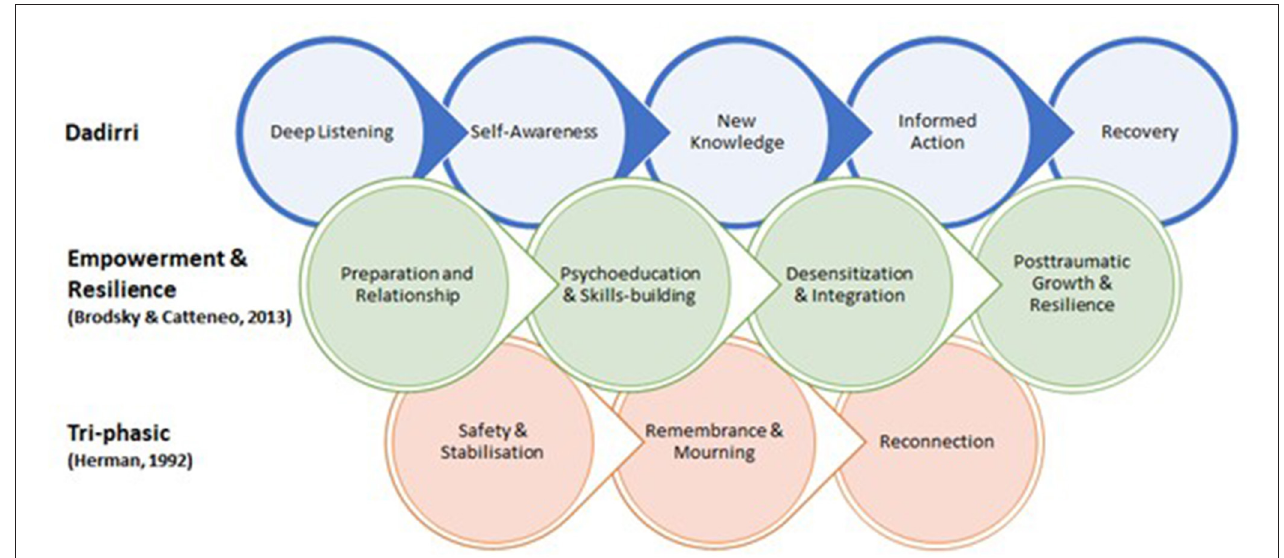
FIGURE 2 | Comparative models of trauma